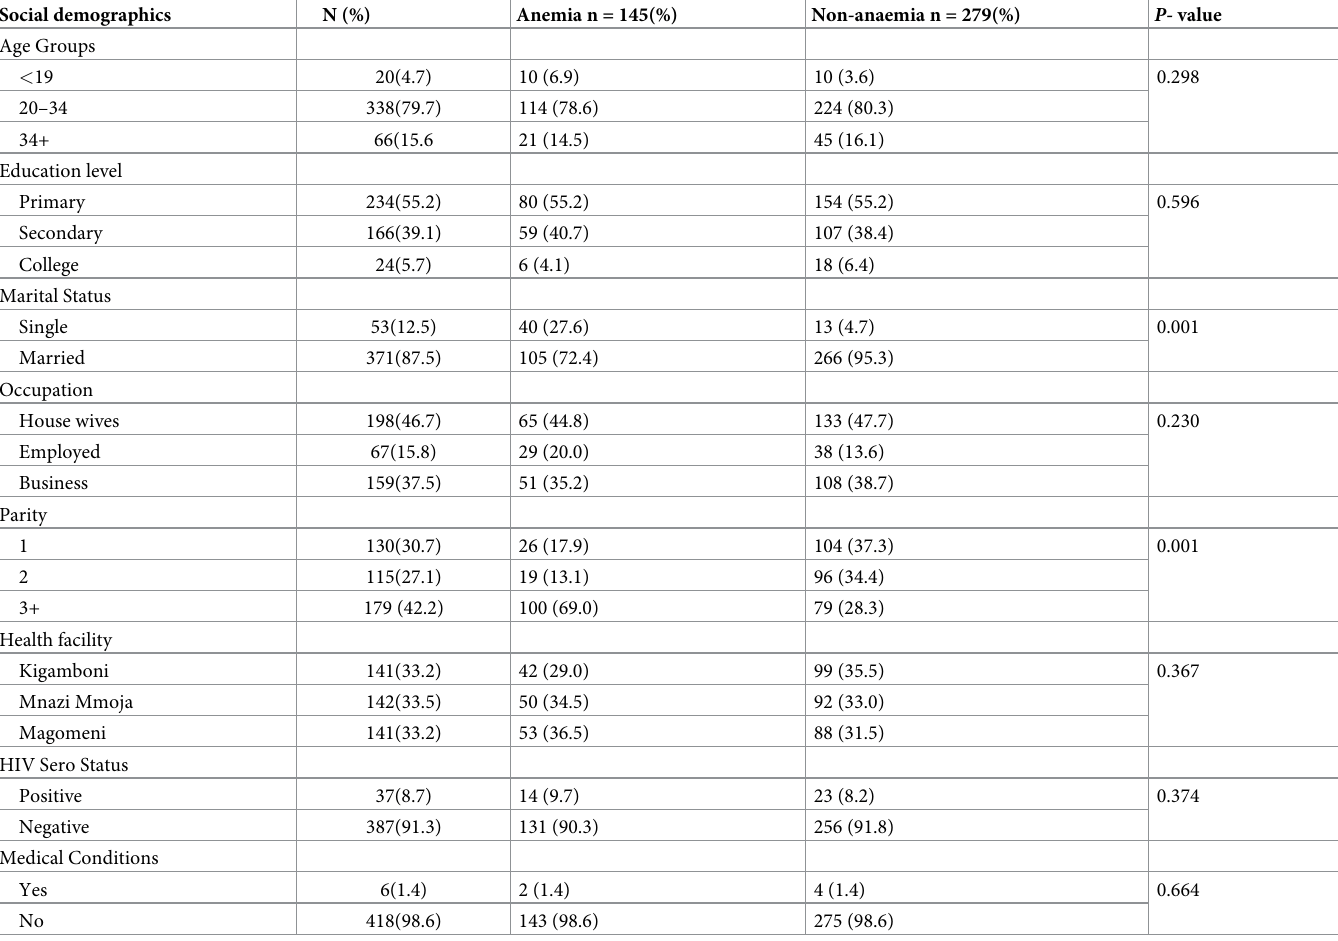
Table 1. Relationship between post-partum anemia and socio-demographic characteristics of women attending Reproductive and Child Health clinics at Mnazi Mmoja, Kigamboni and Magomeni Health Centers (N =